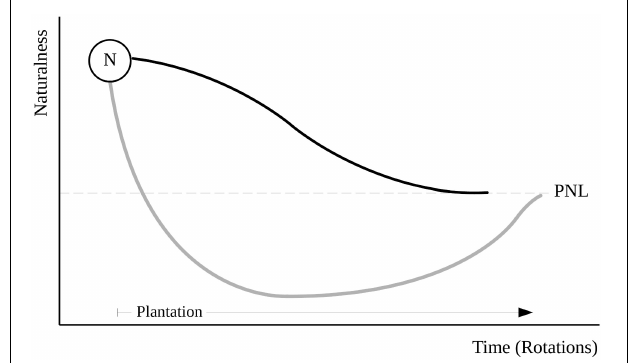
FIGURE 7 | Model for the effect of the conversion of native forests (N) into pine plantations in Central Chile on the level of naturalness of the systems. The black and gray lines represent “soft” and “hard” conversions, respectively. See text for further explanation. PNL and the dashed line represent the plantation naturalness